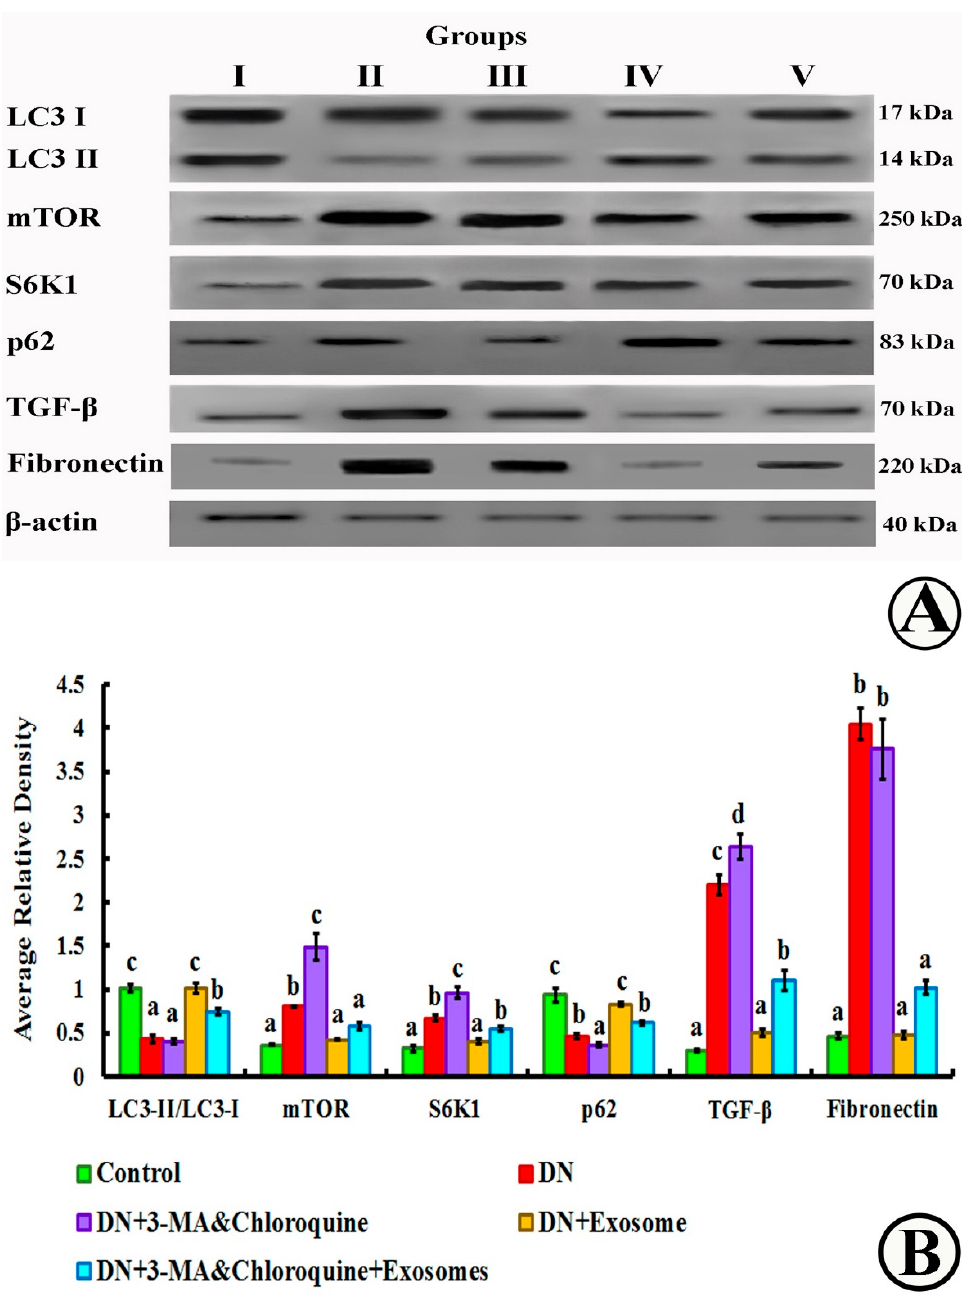
Figure 10. ( A ) Western blot assay and downstream target proteins for mTOR, LC3-I, LC3-II, S6K1, p62 fibronectin, TGF- β , and β -actin expression after treatment with 3-MA, chloroquine, and/or exosomes, and quantified using image analysis software on the ChemiDoc MP imaging system. ( B ) Histogram of blotting intensity in different groups Group I (control), Group II (DN), Group III (DN + 3-MA and chloroquine), Group IV (DN + exosomes), and Group V (DN + 3-MA and chloroquine + exosomes). Subgroup Ic was used as a control. Different superscript letters (a, b, c, and d) within each parameter panel indicate significant differences at p ˂ 0.05. Data are shown as mean ± SEM, n = 5